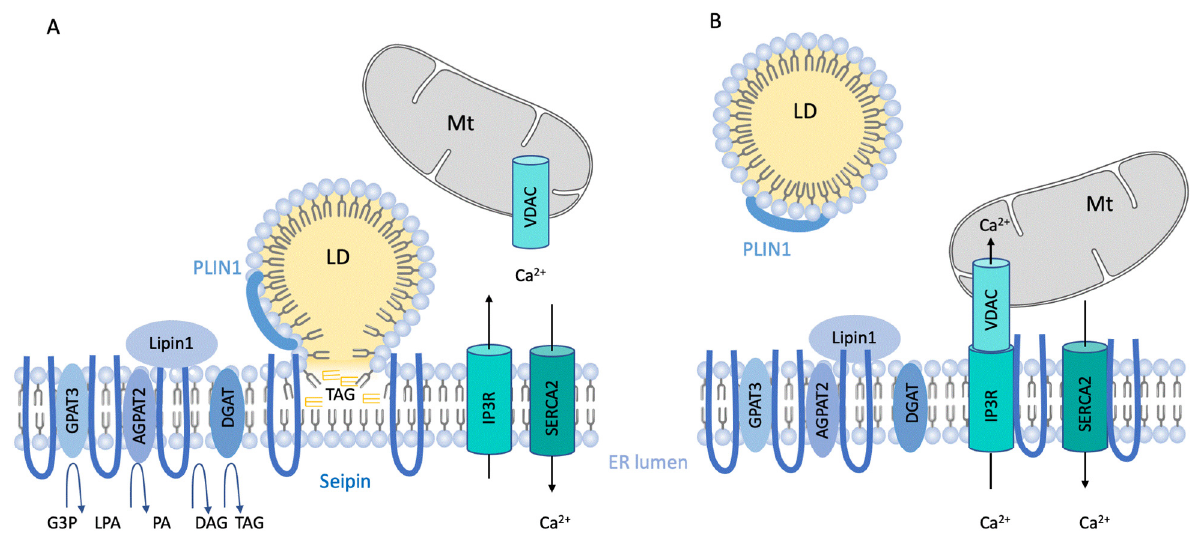
Figure 1. Seipin function in mature adipocytes . Seipin is an ER-anchored protein organized as oligomers. When cells are lipid loaded ( A ), seipin is enriched at the endoplasmic reticulum (ER)/lipid droplet (LD) contact sites and has been shown to be crucial in triglycerides (TAG) flow from the ER to the LD. Seipin interacts with Perilipin1 and with several TAG synthesis enzymes such as glycerol- 3-phosphate acyltransferase (GPAT3), 1-acyl-sn-glycerol-3-phosphate acyltransferase beta (AGPAT2), and LIPIN. No interaction with diacylglycerol acyltransferases (DGAT) has been formally reported. ( B ) -In the fasting state, seipin is enriched at the ER/mitochondria (Mt) contact sites, also named mitochondria-associated membranes (MAM), and participates in ER/mitochondria calcium (Ca 2+ ) flux and mitochondrial activity. Seipin is in close proximity to MAM Ca 2+ regulators IP3(inositol 1,4,5-trisphosphate) receptor (IP3R), voltage-dependent anion channel (VDAC), and sarco-/ER Ca 2+ ATPase 2 (SERCA2) as well as glycerol-3-phosphate (G3P), lysophosphatidic acid (LPA), phosphatidic acid (PA), and diacylglycerol